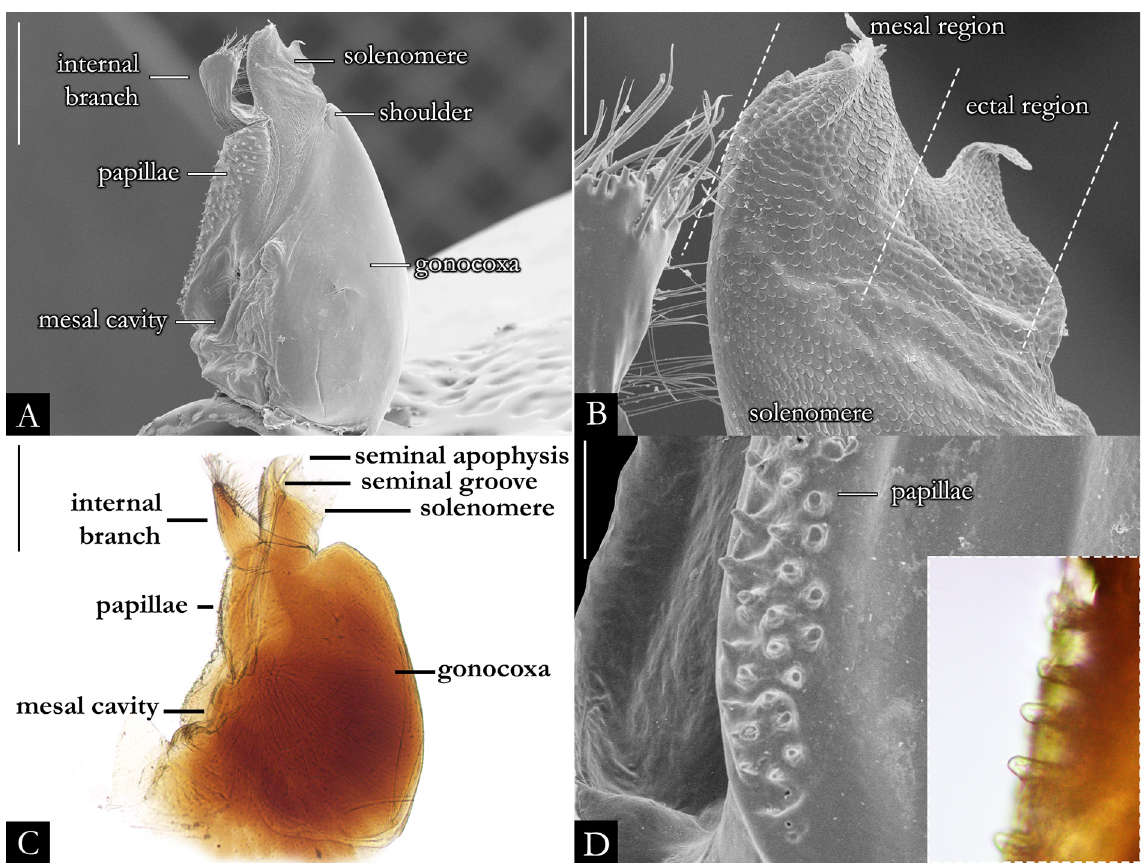
Fig. 36. Microscope and SEM images of right gonopod. A . Pseudonannolene caatinga Iniesta & Ferreira, 2014 (IBSP 2166). B . Telopodite, P. caatinga (IBSP 2166). C . P. microzoporus Mauriès, 1987 (IBSP 3497). D . Gonocoxa, P. microzoporus (IBSP 5733). Detail of the papillae. Scale bars: A, C = 0.5 mm; B, D = 0.1